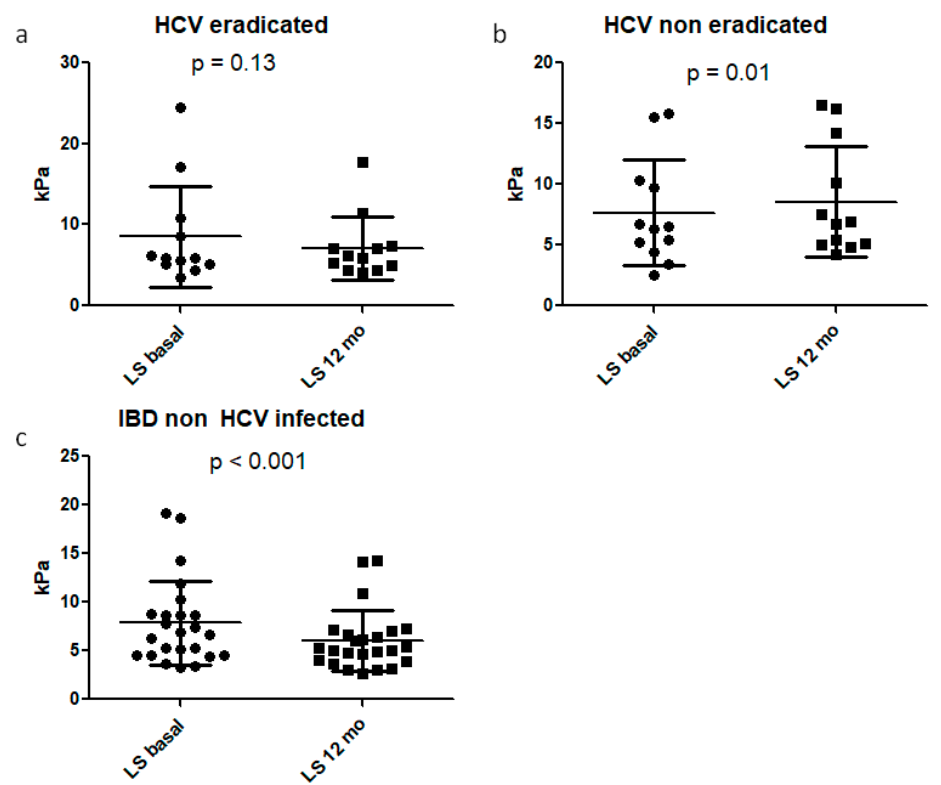
Figure 2. Variations in liver stiffness from baseline to 12 months in IBD patients who eradicated ( a ) or non eradicated HCV ( b ), as well as in IBD control group ( c ).